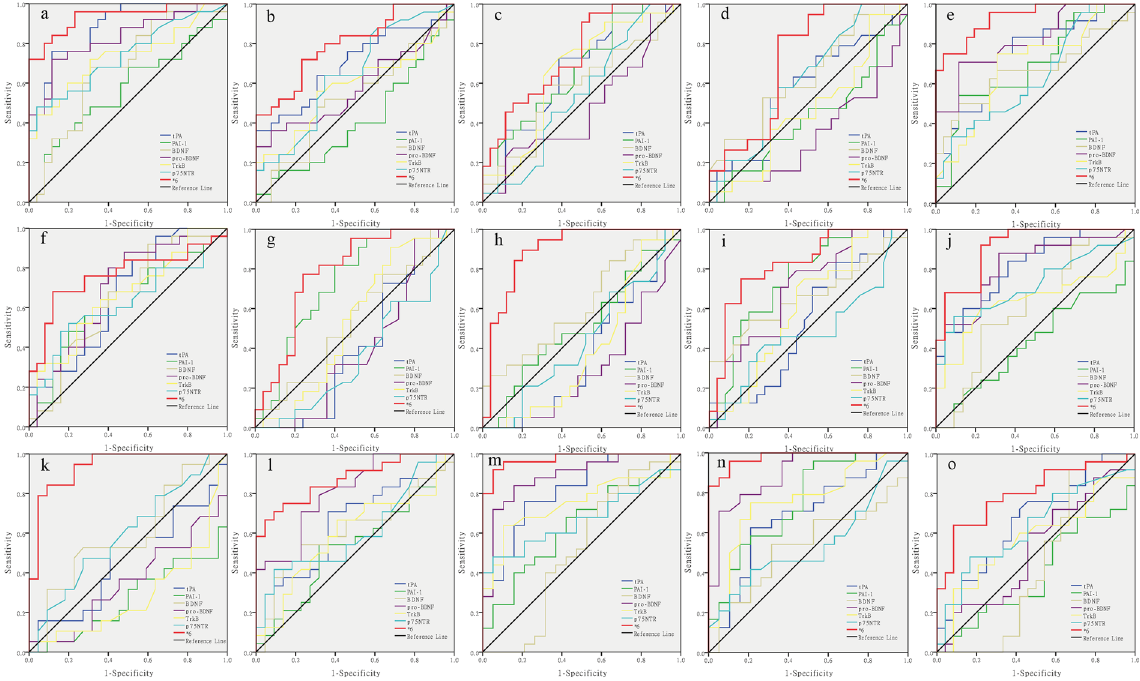
Figure 3. Diagnostic and differential powers of these six serum proteins. ROC curves of each protein and their combination between: ( a ) SZ and HCs. ( b ) SZ and MDD. ( c ) SZ and BM. ( d ) SZ and BD. ( e ) SZ and PD. ( f ) MDD and HCs. ( g ) MDD and BM. ( h ) MDD and BD. ( i ) MDD and PD. ( j ) BM and HCs. ( k ) BM and BD. ( l ) BM and PD. ( m ) BD and HCs. ( n ) BD and PD. ( o ) PD and HCs. ROC, the receiver operative